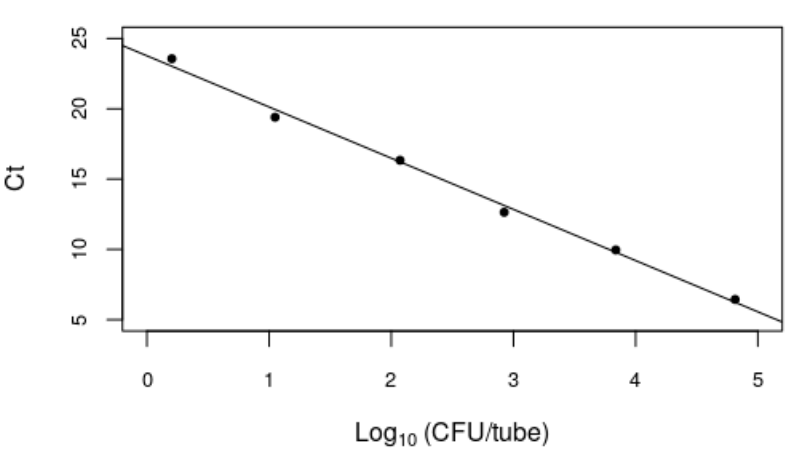
Figure 2. Calibration curve of nested real-time PCR assay using the Zur1-CAE-rev, Zur2-EAC-fwd primer pair and Zur1-TP probe (Table 1) and dilution of Xcc added to soil.